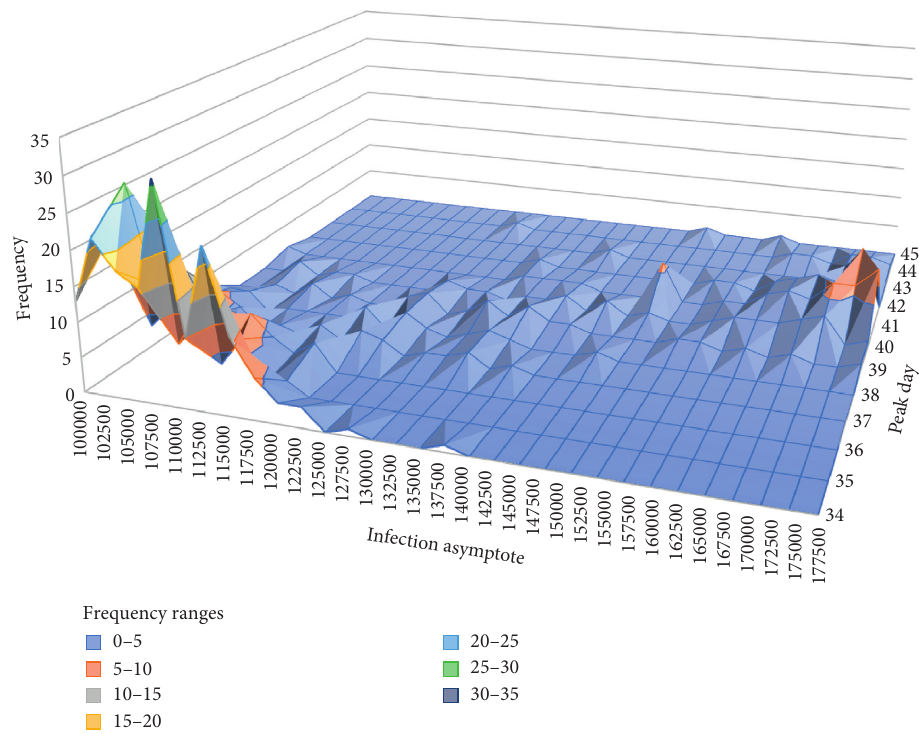
Figure 3: COVID-19 bootstrap (AsymptoteClass, Peak day) distribution.